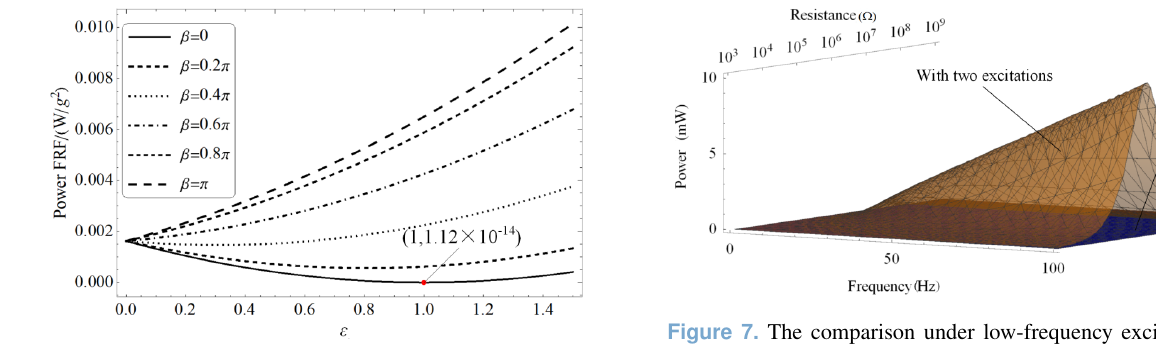
Figure 6. Power FRF with respect to the variation of ε ( R = 10 5 (cid:127) , a 2 = 0.5, (cid:36) = 2Hz).